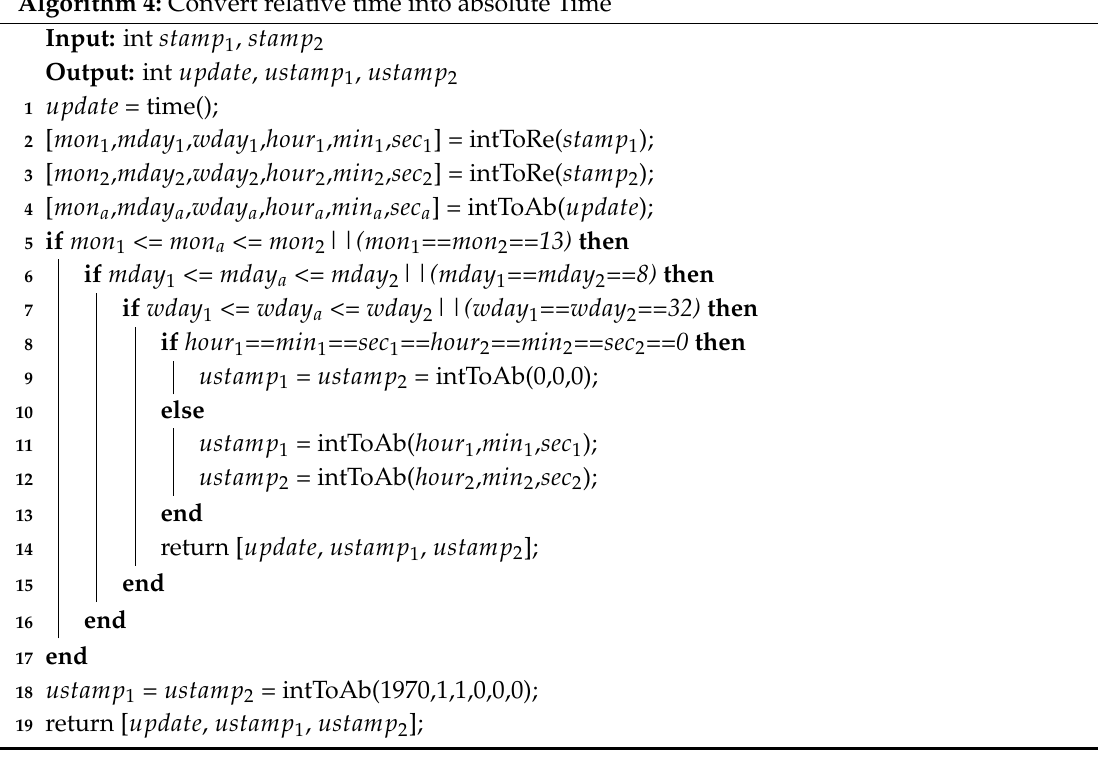
Algorithm 5: Update time